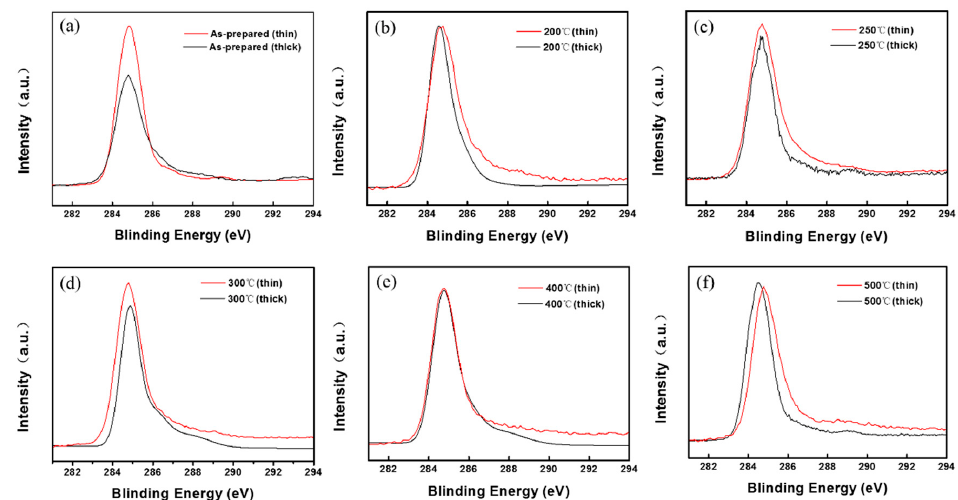
Figure 5. The XPS spectra of thick and thin FL-C:H films, ( a – f ) is original films and heat treatment films with annealed temperatures of 200, 250, 300, 400, and 500 °C, respectively.